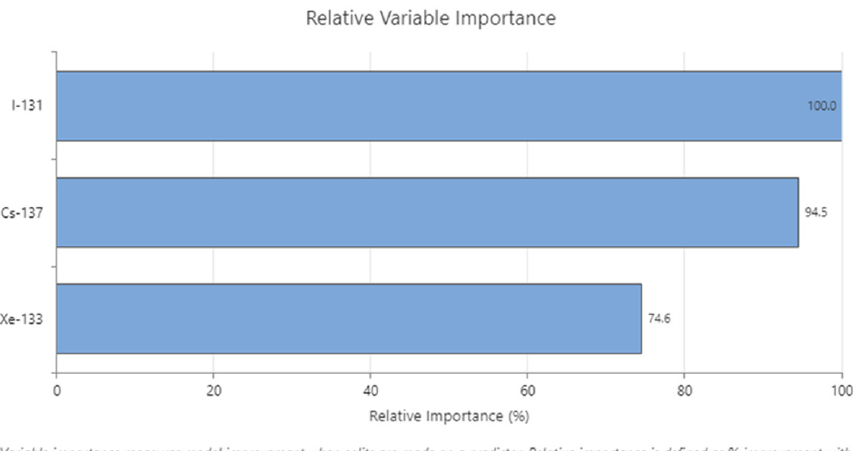
Figure 2. Graph showing the relative importance of the predictors for August (summer) .